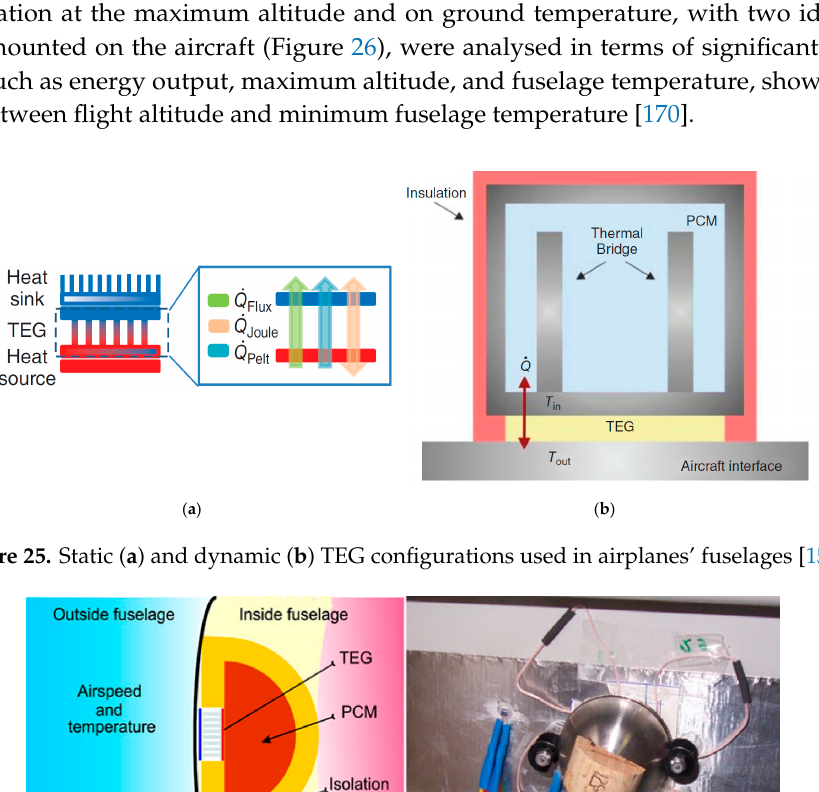
Figure 26. Scheme of the TEG mounting ( a ) and its factual installation close to the front left door on a DL-R A320 D-ATRA aircraft ( b ) [170].